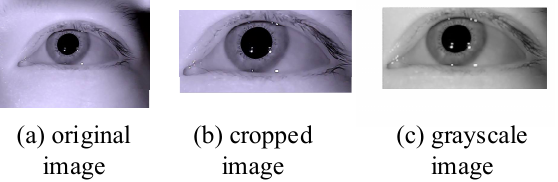
Figure 2. Preprocessing result. ( a ) Original image; ( b ) Cropped image; ( c ) Grayscale image.